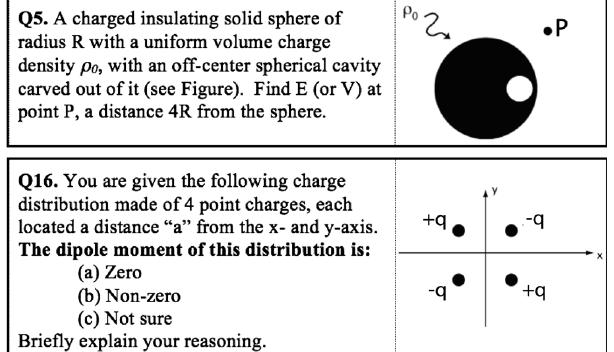
FIG. 7. Questions 5 and 16 reproduced from the FR version of the CUE [15].